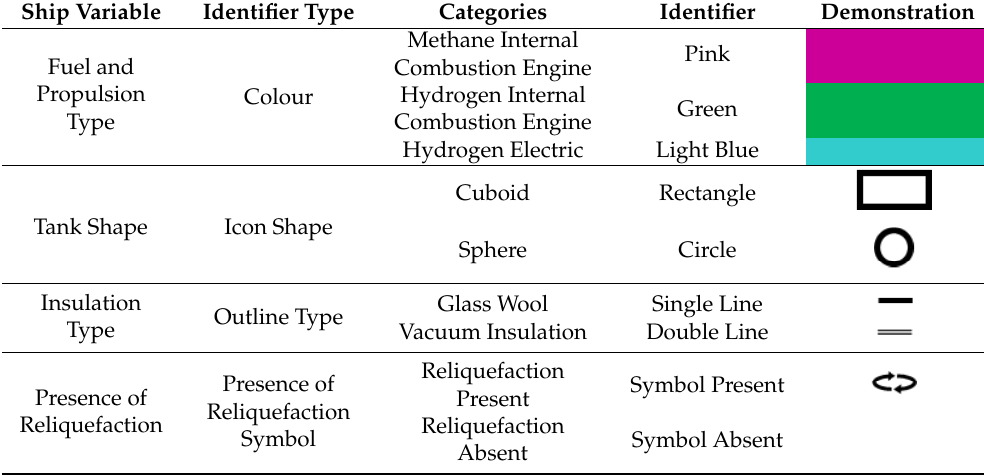
Table A6. Key to identify the symbols that represent all investigated ship designs.